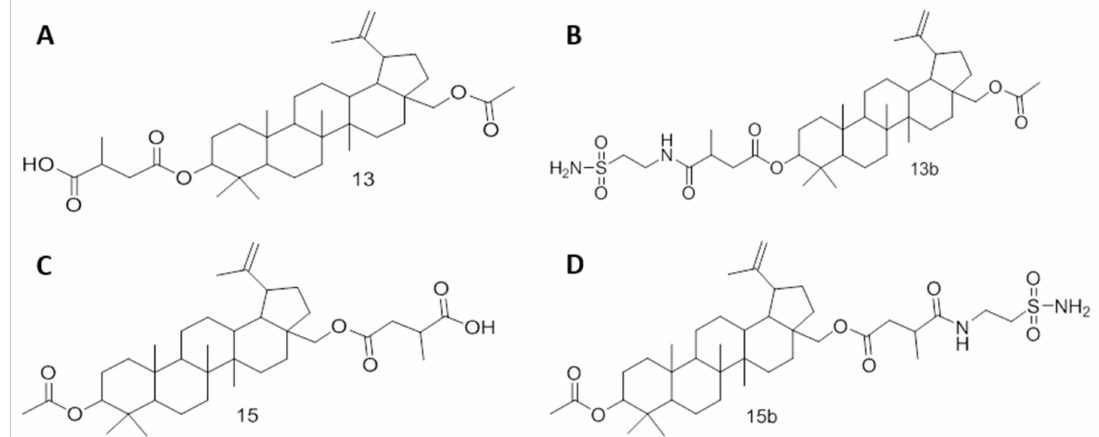
Figure 1. Structures of betulin derivatives. Betulin derivatives 13 ( A ) and 15 ( C ) are precursors of betulin sulfonamides 13b ( B ) and 15b ( D ). Although 13 and 15 contain acid groups in positions C3 and C28, respectively, 13b and 15b carry sulfonamide groups in these positions.